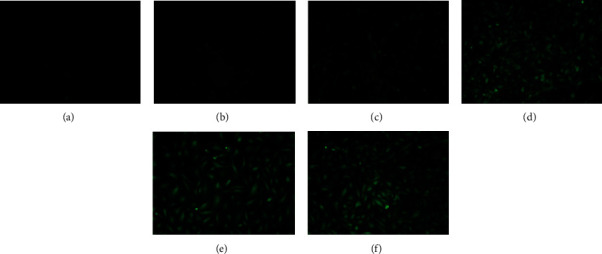
Fluorescence expression of blank controls at 72 h after transfection with different MOI. All cell groups were cultured in complete medium. (a) MOI = 1. (b) MOI = 5. (c) MOI = 10. (d) MOI = 20. (e) MOI = 50. (f) MOI = 100.